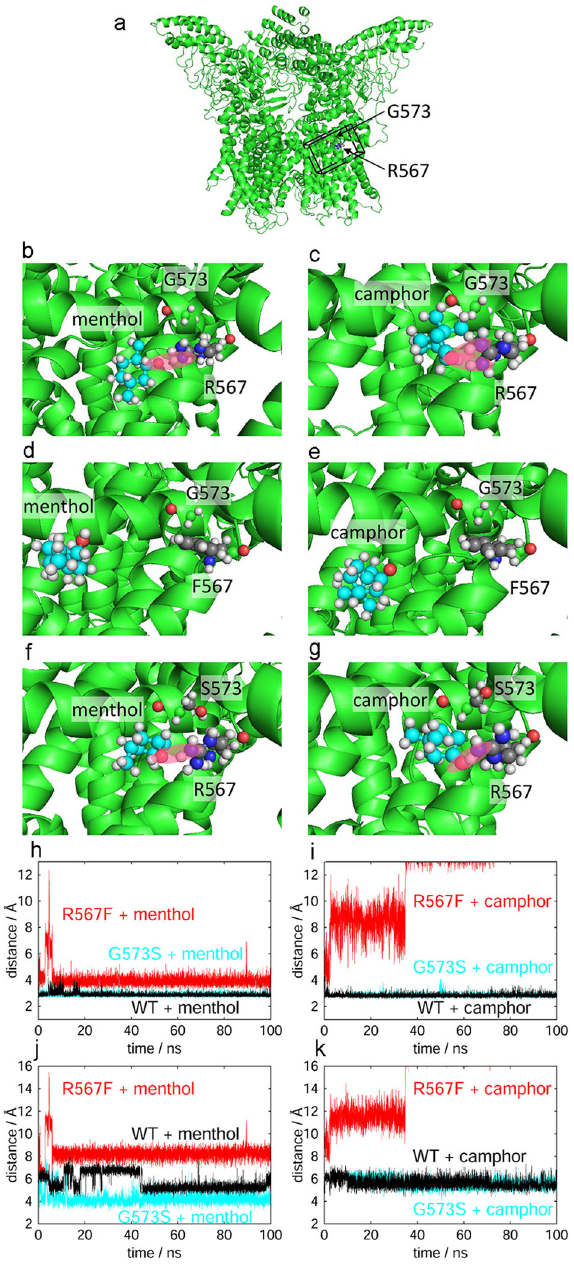
Fig. 7 Molecular dynamics simulation con fi rming a stable bond between monoterpenes and R567. Representative snapshots of a the whole WT TRPV3 system, b menthol in WT TRPV3, c camphor in WT TRPV3, d menthol in mTRPV3-G573/R567F, e camphor in mTRPV3-G573/R567F, f menthol and mTRPV3-G573S/R567, g camphor and mTRPV3-G573S/ R567. Black frame in a represents the area we focus in b – g . Pink highlights indicate hydrogen bonds between monoterpenes and R567. Time series of distance between h menthol and R567/F567 and i camphor and R567/ F567. Time series of distance between j menthol and G573/S573 and k camphor and